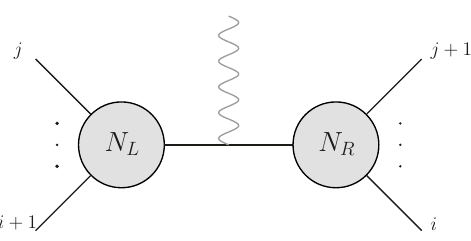
Figure 9 . The second type of Feynman diagram which contributes to the sub-leading soft operator. The gray wave line denotes the soft